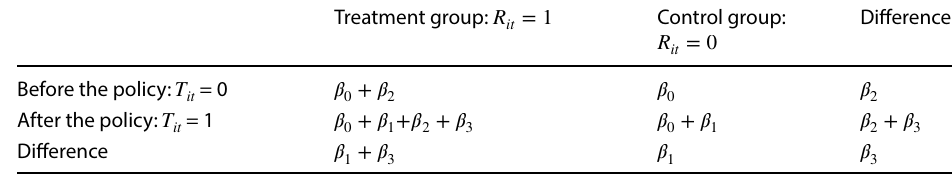
Treatment group: R it = 1 Control group: